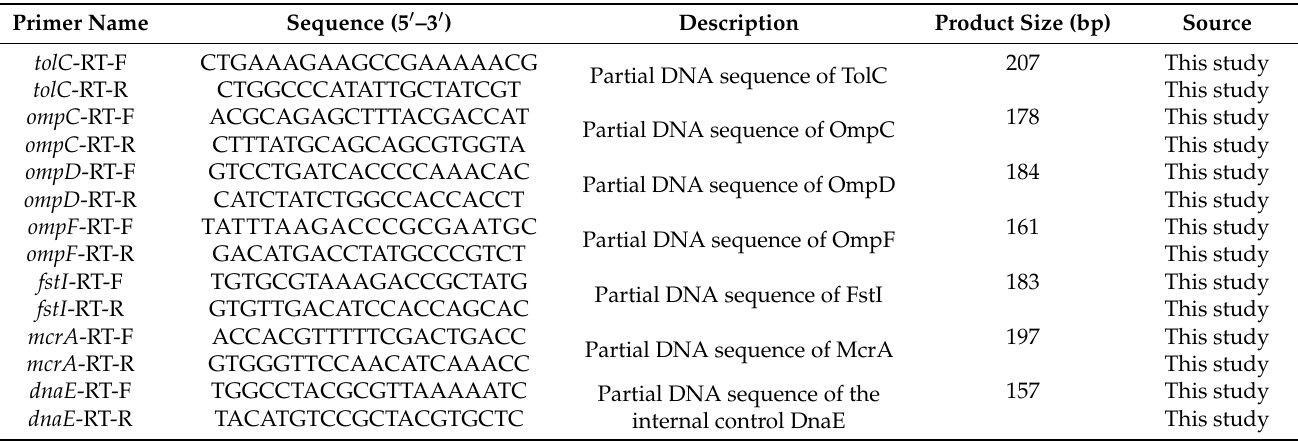
Table 1. RT-qPCR primers used in this